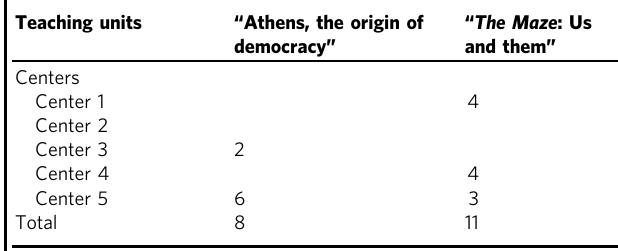
Table 1 Teaching units by educational